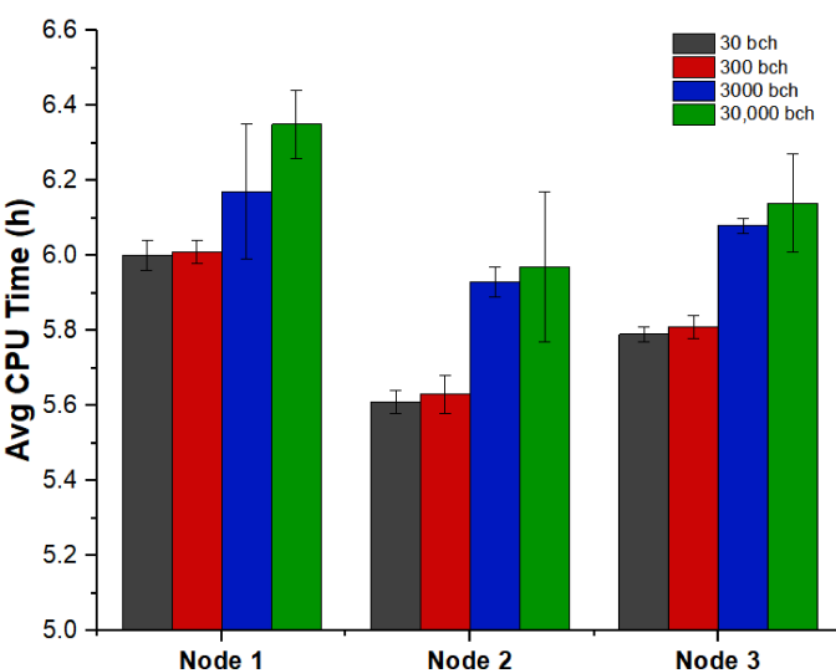
Figure 7. Individual node performance was evaluated using only three processors each. The aver- age value of five average CPU times required to repeat 3 × 10 8 computational simulations for the PDD in a 10 cm × 10 cm field size was analyzed. Table 5. Prior to cluster evaluation, calculations were performed with three processors each to